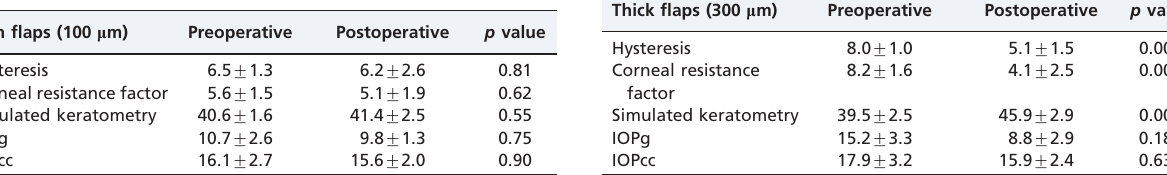
Table 1 - Preoperative and after flap creation ( ¡ SD) hysteresis, corneal resistance factor, simulated keratometry mean, Goldmann-correlated intraocular pressure (IOPg) and corneal-compensated intraocular pressure (IOPcc) for the 100 m m flap group and respective p values.